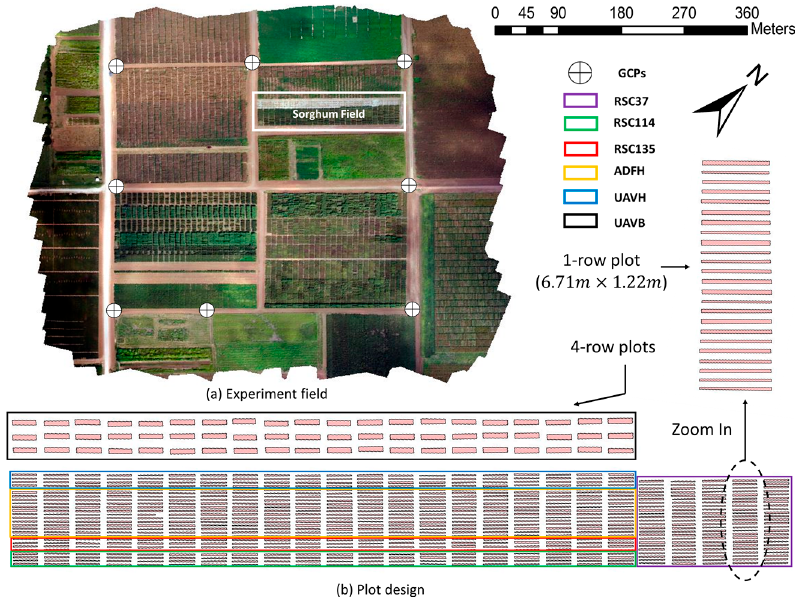
Figure 1. ( a ) Experiment field at Texas A&M AgriLife Research Farm. ( b ) Overview of the plot design in sorghum field with 700 plots.